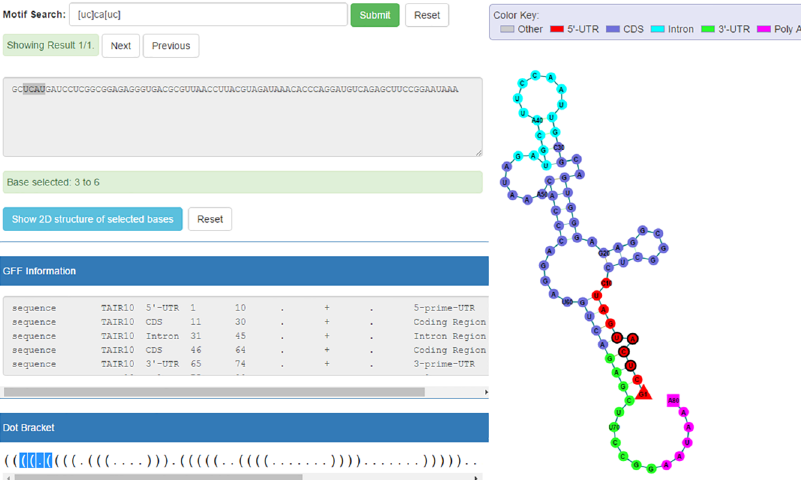
Fig 1. Web interfacesof RNA secondarystructure prediction results. The web pageshows the nucleotide sequence, genicannotation,DBN data, and secondary structure graph. In particular,the sequencesegments with different annotation features (i.e., 5’ UTR, CDS, intron, 3’ UTR, etc.) are labeledwith different colors. For demonstration purpose,we used the motif search function to search for the motif “[UC]CA[UC]” in this sequence, and found 1 match, which is highlighted in the nucleotidesequence, DBN data, and secondary structure graphcorrespondingly.